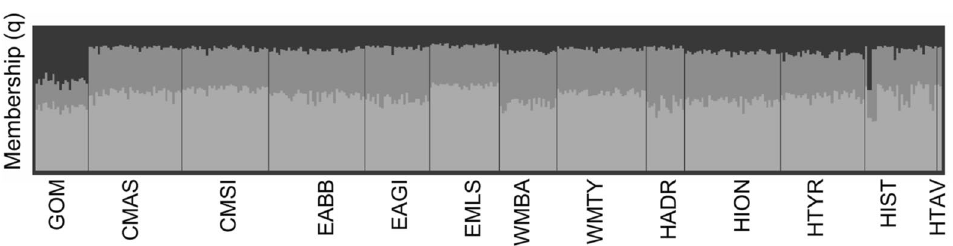
Figure 3. STRU CTU RE barplot showing membership probabilities (q) for each sample group analysed herein with K = 3 (each represented by a different shade). K = 3 was the most likely number of populations identified by the ΔK method. Historical (archival and archaeological) sample groups are denoted with